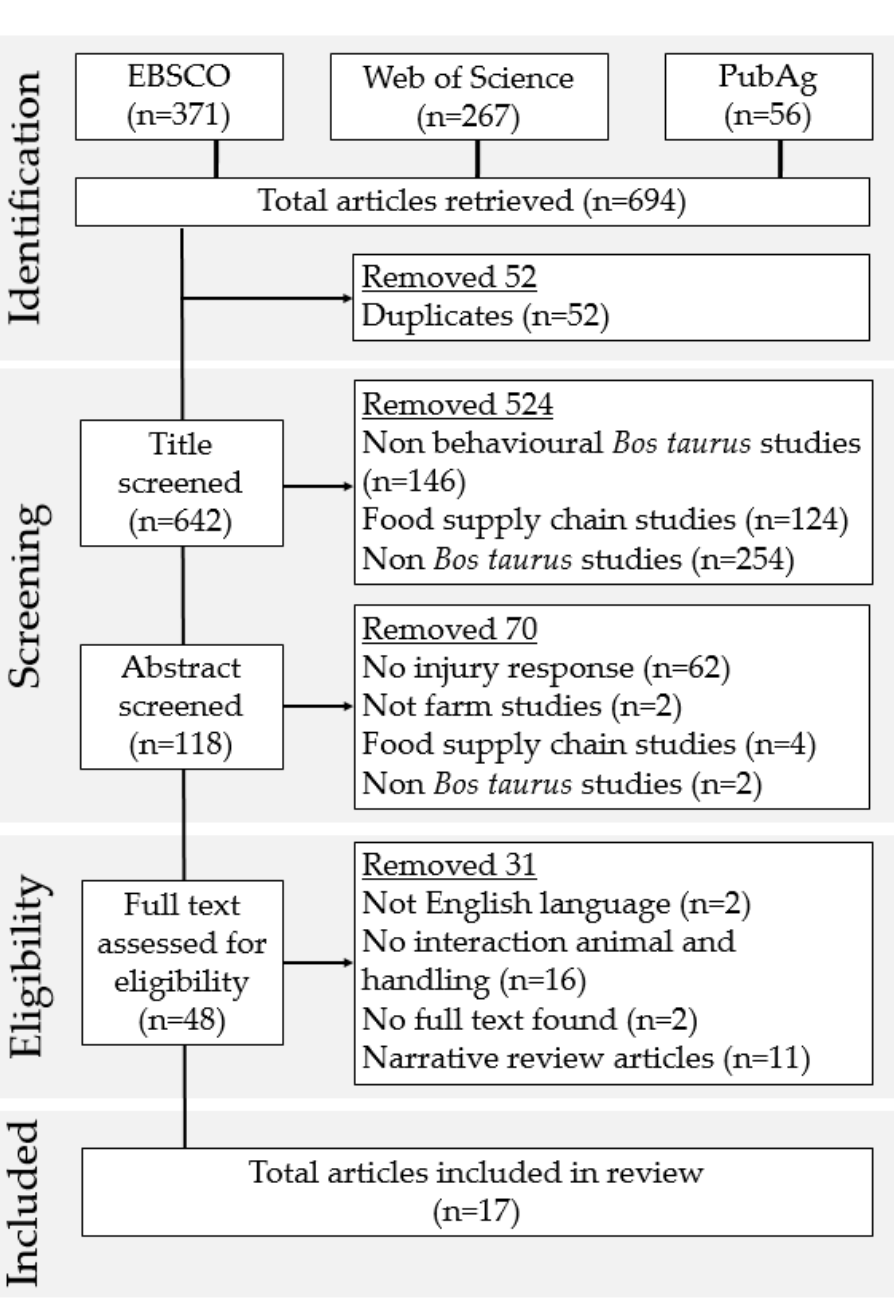
Figure 1. Article selection process detailing the number of articles included and excluded at each step of the review using the PRISMA (Preferred Reporting Items for Systematic Reviews and